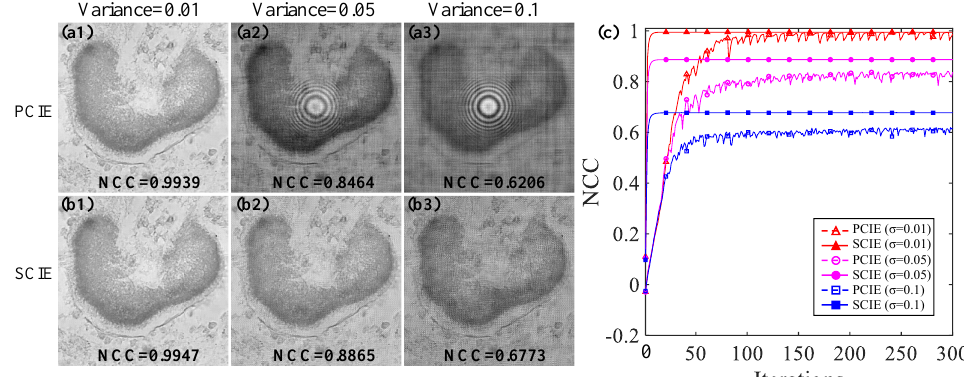
Figure 5. Noise robustness of PCIE and SCIE. ( a1 – a3 ) the reconstructed images with the variance of 0.01, 0.05, and 0.1 for PCIE; ( b1 – b3 ) the reconstructed images with the variance of 0.01, 0.05 and 0.1 for SCIE; ( c ) NCC curves.